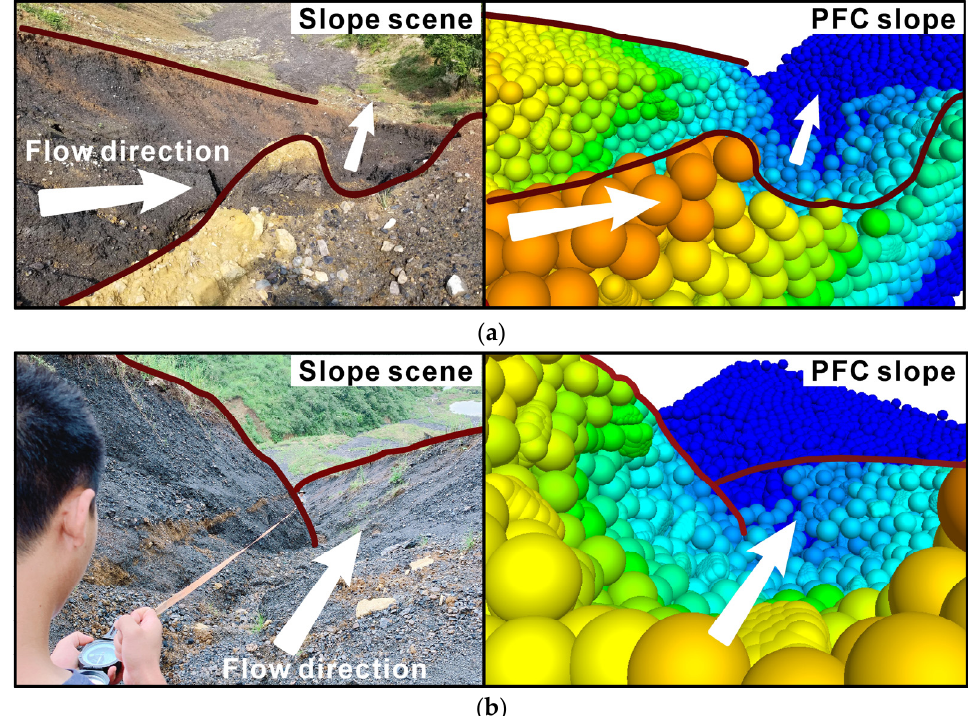
Figure 12. Comparison of the gully simulated by the site and by the PFC. ( a ) comparison Figure 1, ( b ) comparison Figure 2.